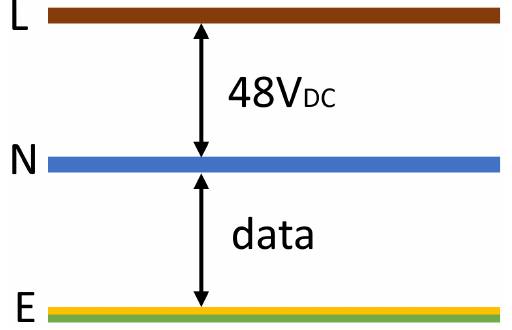
Figure 9. Powering and communication over the 3-wire electrical